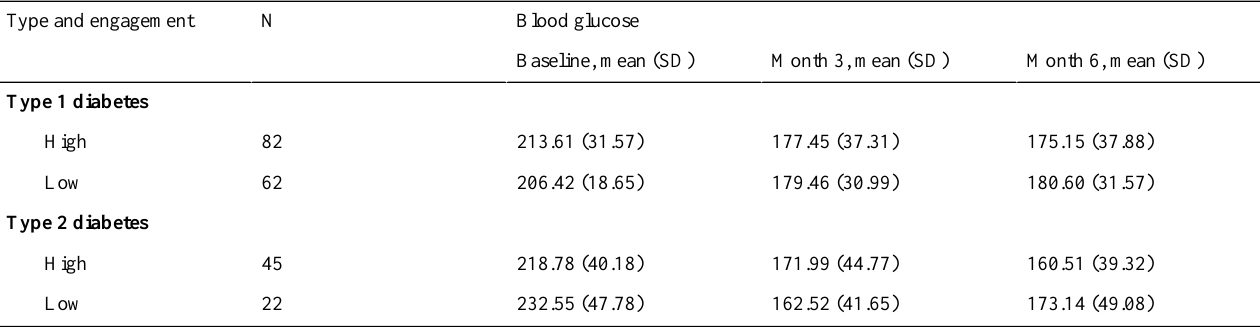
Table 1. The evolution of blood glucose in type 1 diabetes and type 2 diabetes users.